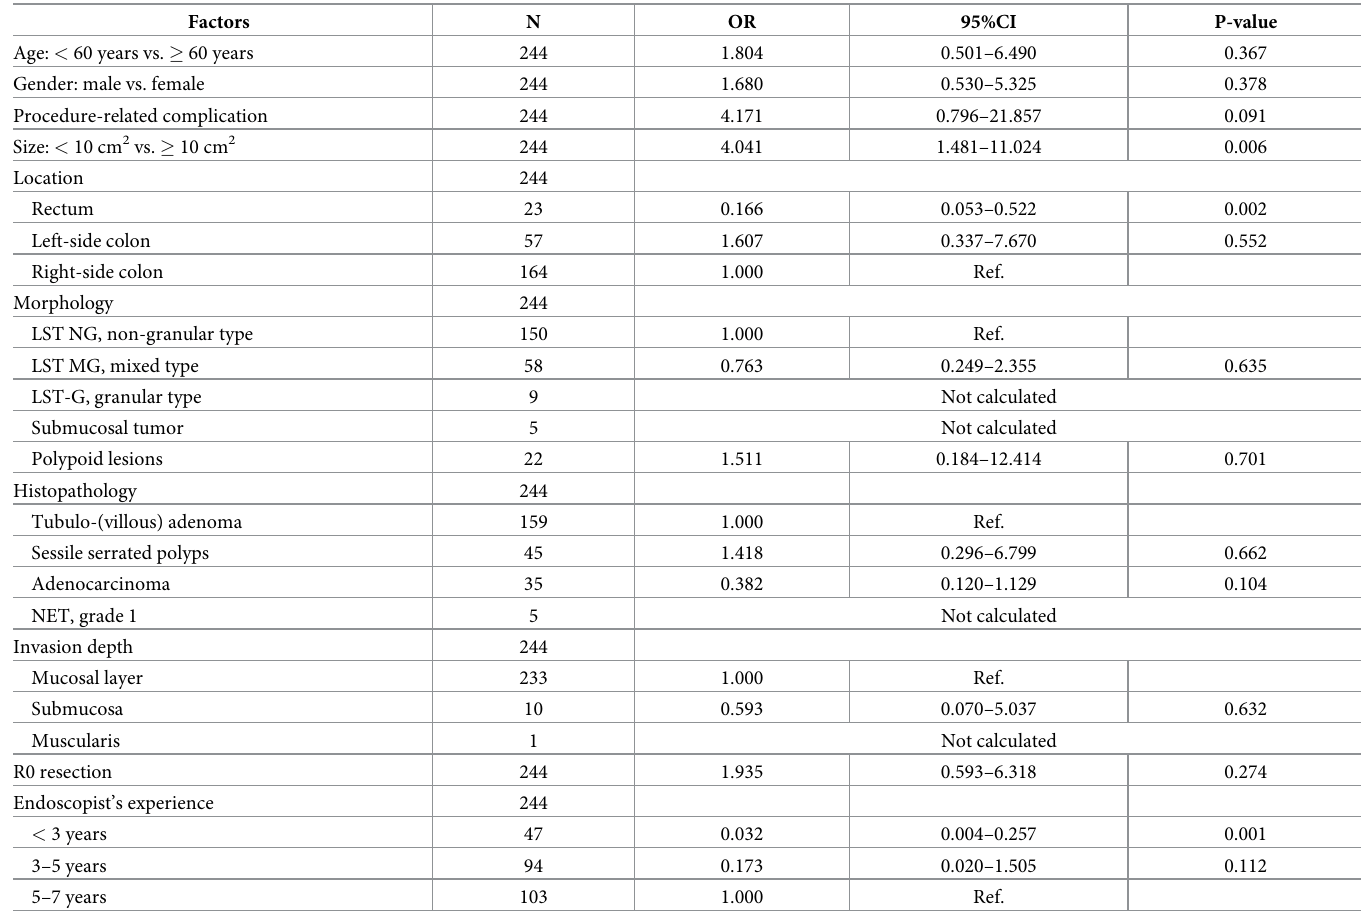
Table 4. Univariate logistic regression analysis for long ESD time (procedure time � 100 min).